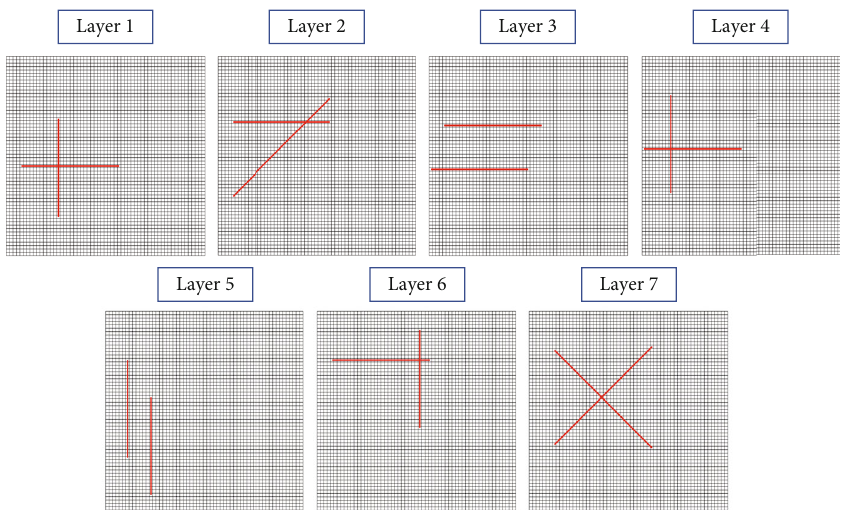
Figure 20: Fracture distribution of di ff erent layers for egg